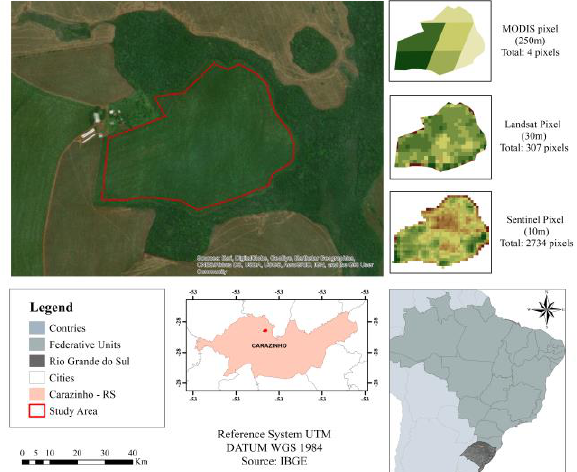
Figure 1. Study area location and pixel size of each orbital sensor used. Carazinho/RS, 2017/18.